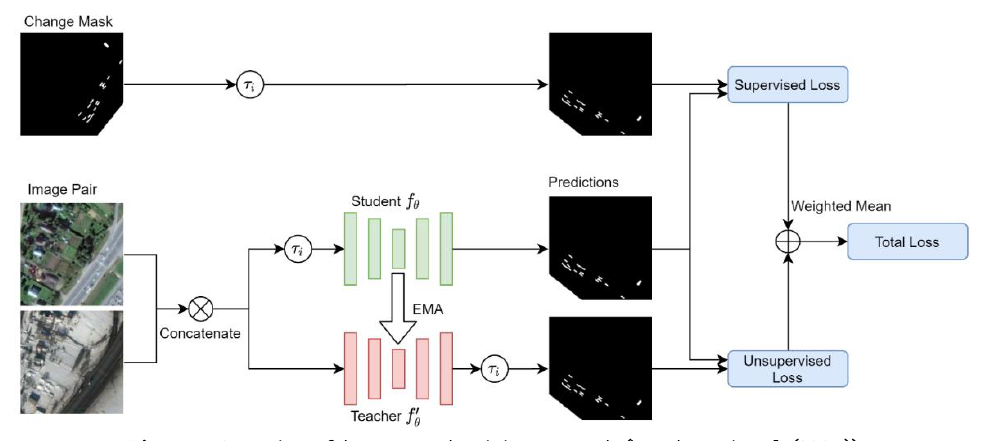
Figure 1: Overview of the proposed training approach (based on Li et al. (2021)).